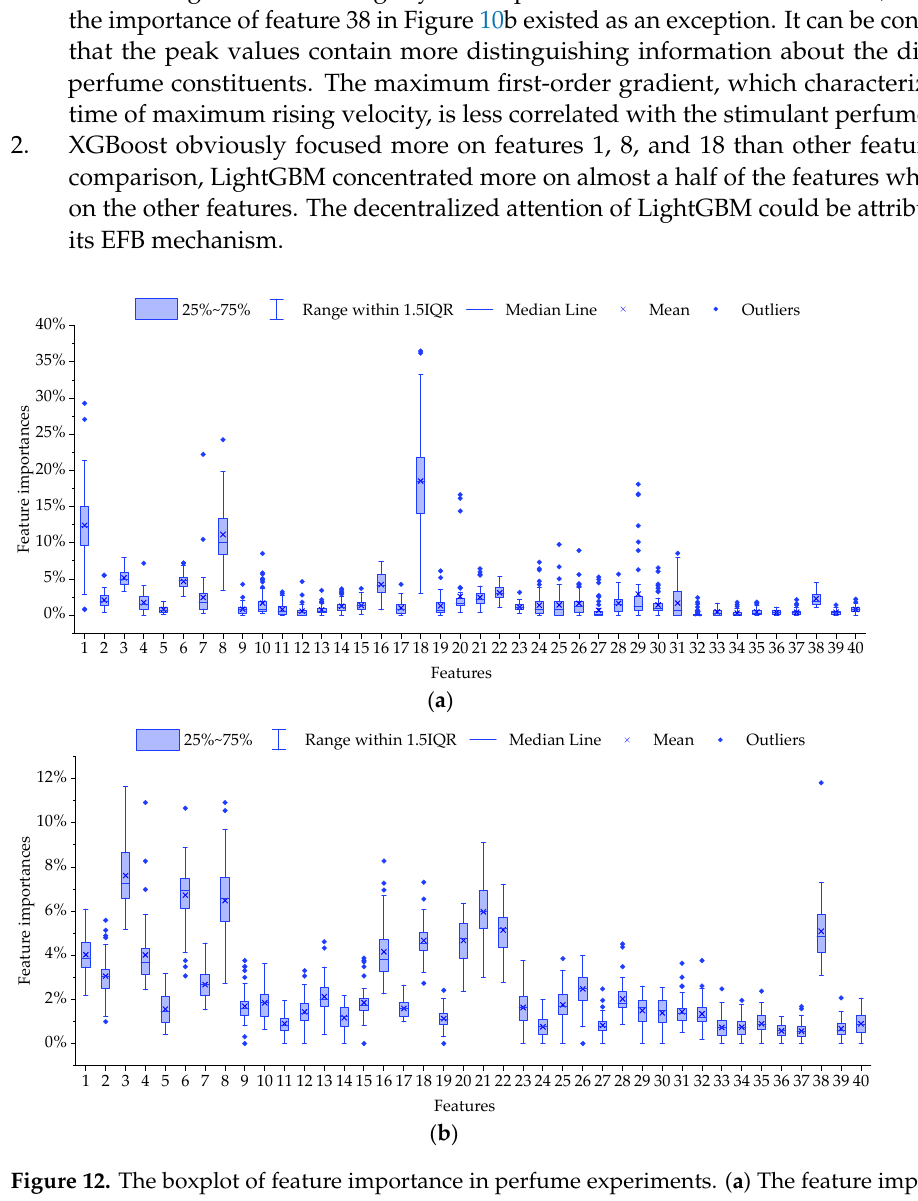
( c ) Figure 13. Statistical results obtained in liquor experiments. ( a ) Boxplot of the identification accura- cies. ( b ) Boxplot of the time spent for training. ( c ) Boxplot of the time spent for prediction.